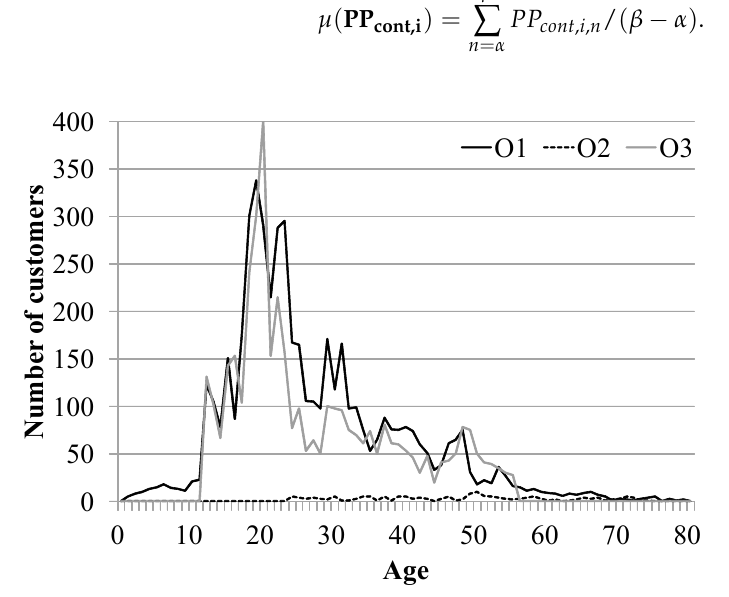
Figure 3. An example of age curve.